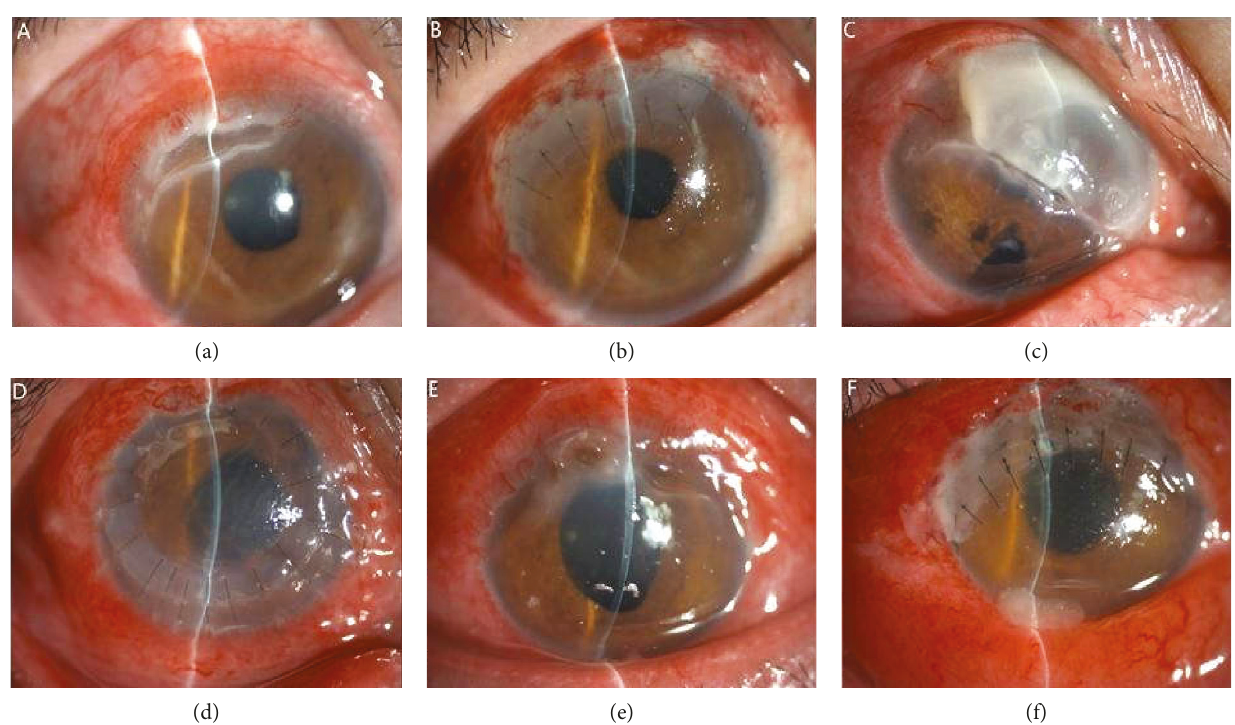
Figure 1: Slit lamp photograph of 3 patients with Mooren ulcer. (a) A 40-year-old man was fi rst diagnosed with Mooren ulcer.